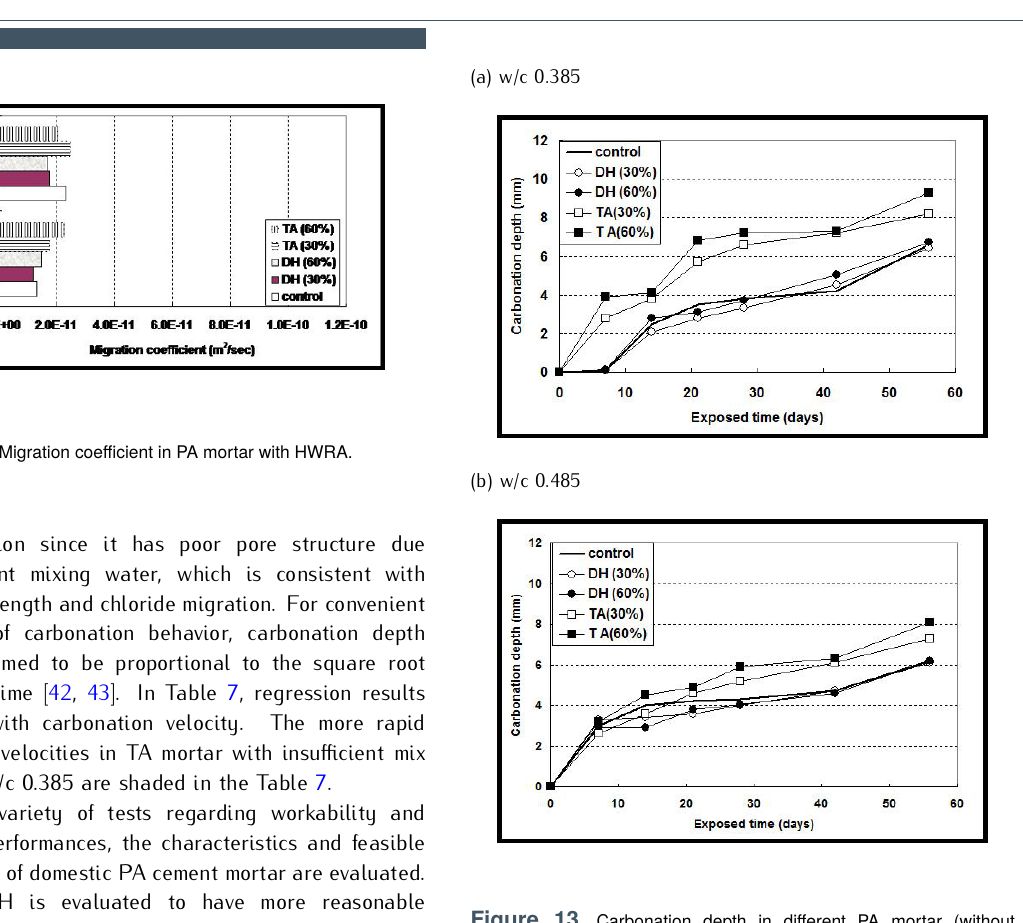
Figure 13. Carbonation depth in different PA mortar (without